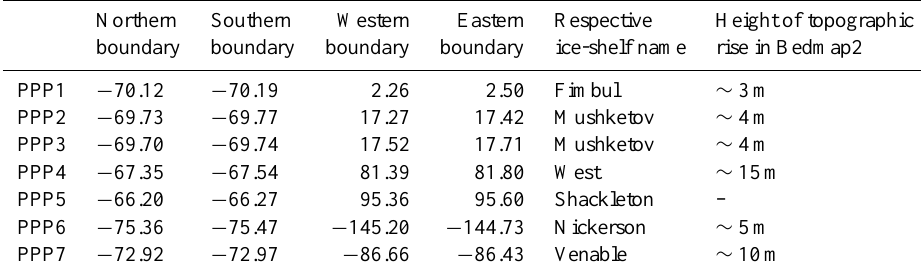
Table 2. Decimal longitudinal and latitudinal range where we find evidence for potential pinning points (PPP). Also given are the respective shelf names. The ice shelf east of Verblyud Island has no name. As its main tributary is Mushketov Glacier, we refer to it as Mushketov Ice Shelf. If a peak in the Bedmap2 surface elevation is discernible, its height is manually estimated with respect to the surrounding shelf surface. If no peak is identifiable, no number is given